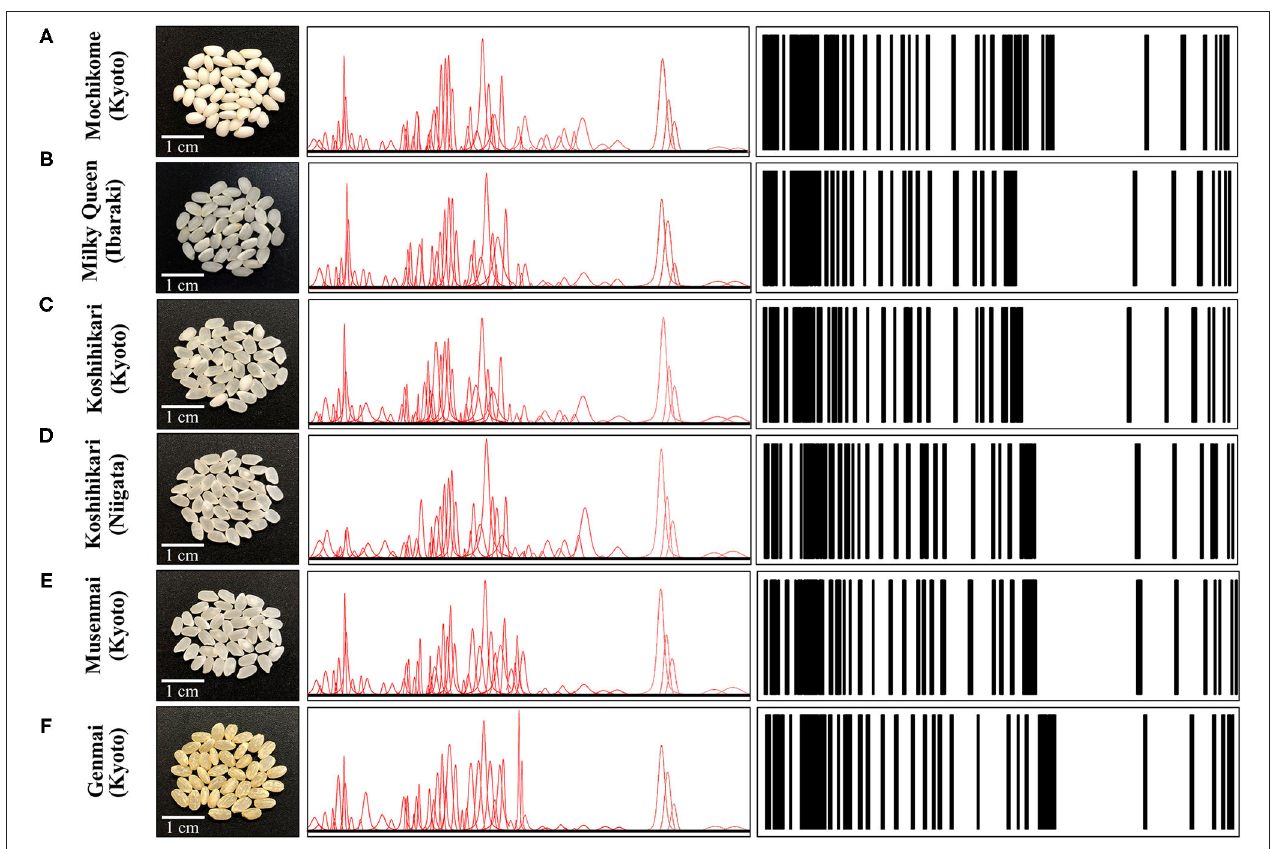
FIGURE 10 | Laser microscopy images of kernel cross sections from six different Japanese rice cultivars (A) Mochikome (Kyoto), (B) Milky Queen (Ibaraki), (C) Koshihikari (Kyoto), (D) Koshihikari (Niigata), (E) Musenmai (Kyoto), and (F) Genmai (Kyoto). Photographs of the kernels of six popular Japanese rice cultivars (cf. insets), the Voigtian sub-band sequences derived from their related Raman spectra, and the computed barcodes according to the algorithm shown in Figure 9B